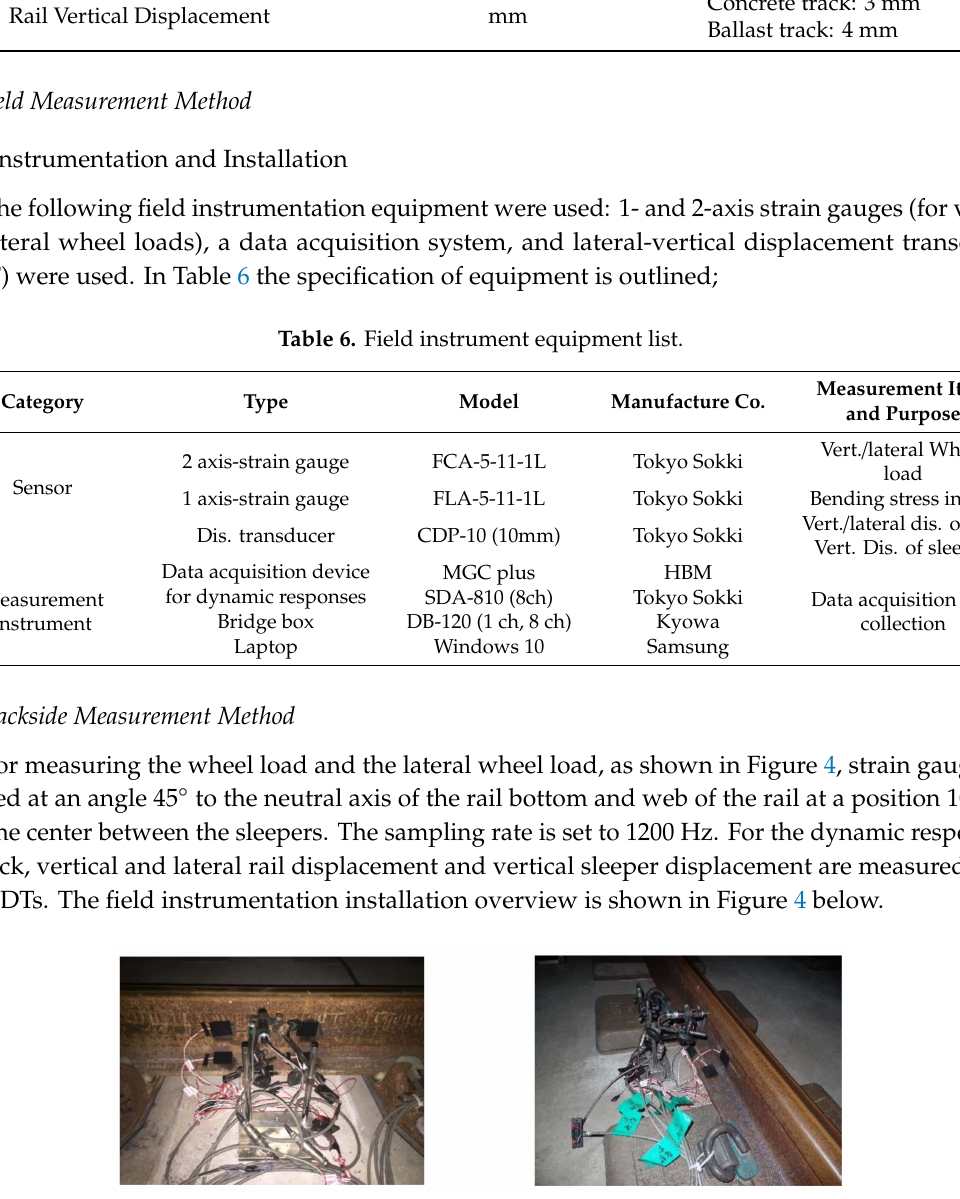
Figure 4. Strain gauge and LVDT installation